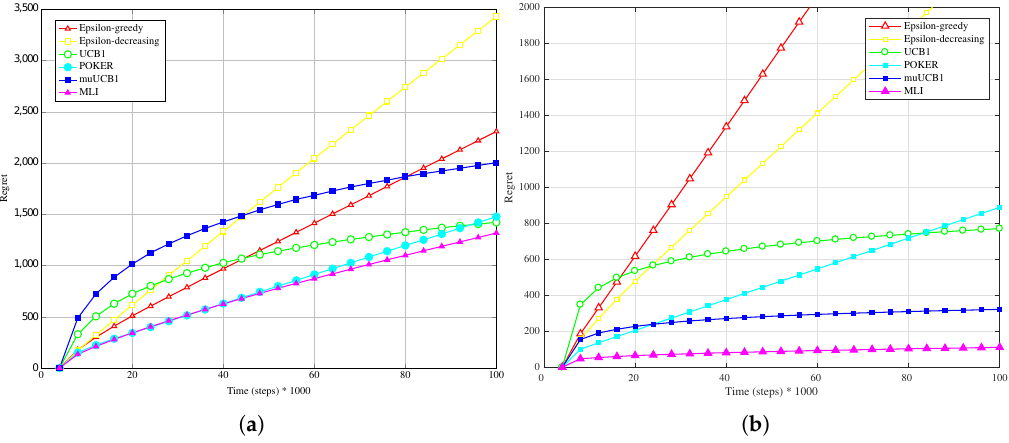
Figure 5. Performance in terms of regret of the six considered algorithms, with a truncated Gaussian distribution for the reward PDF and T U / T M = 5. ( a ) Hard configuration; ( b ) Easy